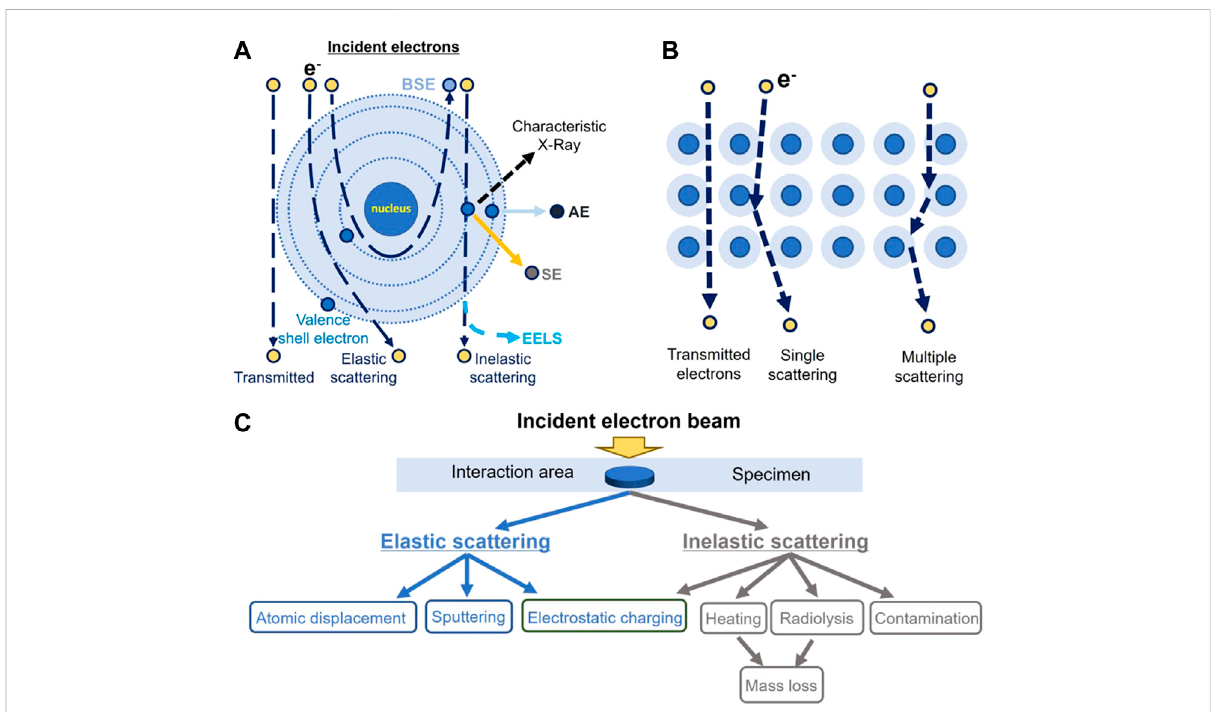
FIGURE 2 Schematic illustration of the interaction between the incident electrons and the atoms of specimen. (A) Schematic diagram of the described electron beam interacting with an atom in the sample, including the nucleus and electron cloud/shells. AE stands for Auger electron; BSE, for backscattered electron; SE, for secondary electron; and EELS, for electron energy-loss spectra. (B) Schematic diagram of the described scattering pathway of an incident electron within the sample. (C) Classi fi cation of radiation damage induced by electron